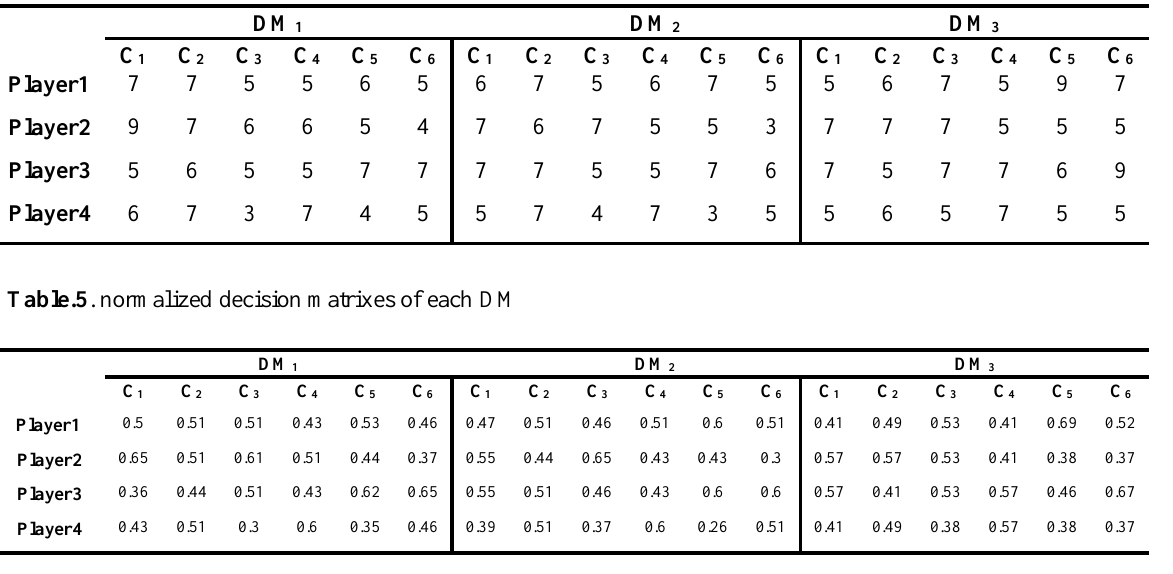
Table.6 . weighted normalized decision matrix of each